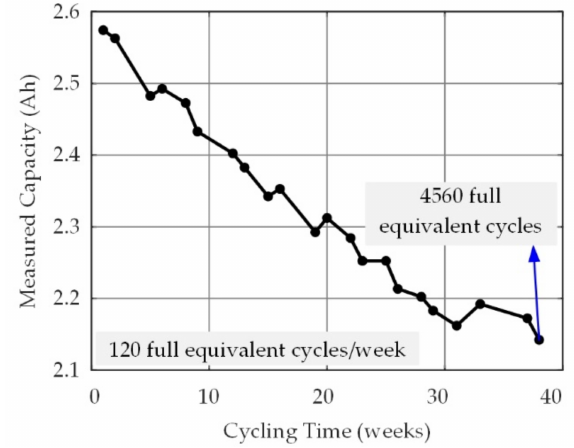
Figure 3. Capacity test of the tested battery